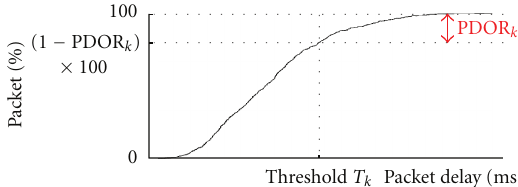
Figure 3: Example packet delay CDF and experienced